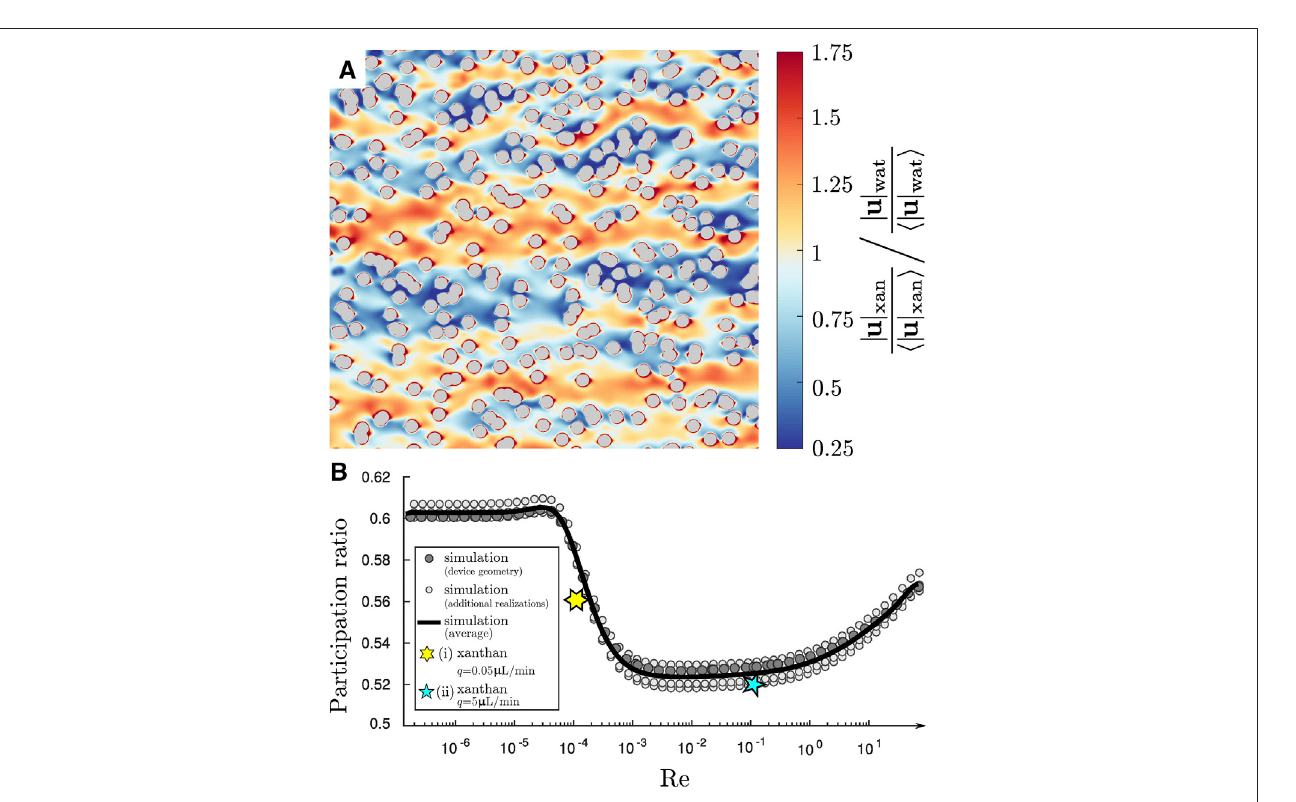
FIGURE 3 | (A) Contour plot of the ratio between the local velocity magnitudes measured with the non-Newtonian (xanthan) and Newtonian (water) fl uids, normalized by the corresponding mean velocities in the observation mid planes, both obtained at qin 5 µL/min. (B) Participation ratio as a function of Reynolds number. Gray markers label the participation values obtained from the simulations of four different realizations of the pore structure. The realization which corresponds to the experimental device is marked in darker gray. The black solid line was obtained by averaging the four realizations of the “ swiss-cheese ” pore geometry. The participation ratiocalculated fromtheexperimentally measured velocity fi elds ofthexanthan gum solutionat q in 0.05µL/min and q in 5µL/min arelabeledwithyellow and blue stars, respectively.